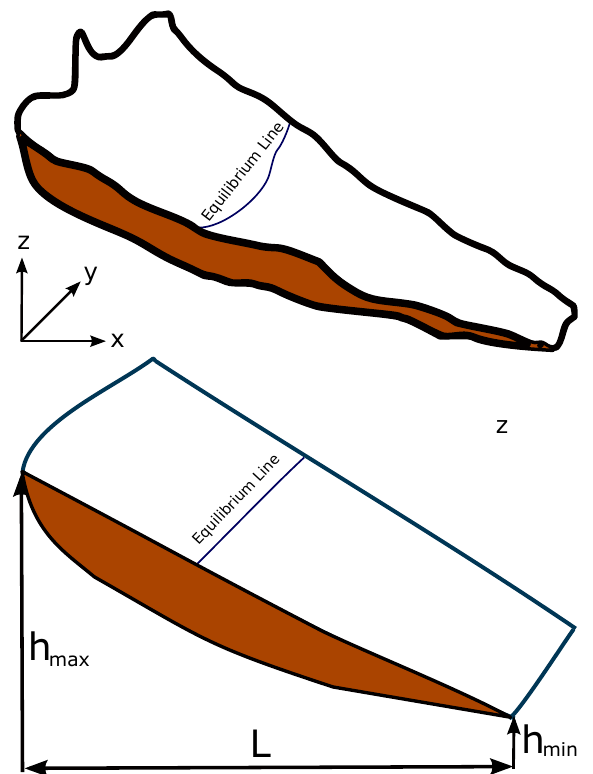
Fig. 2. Schematic view of a glacier and an idealized version (incline with same mean slope).